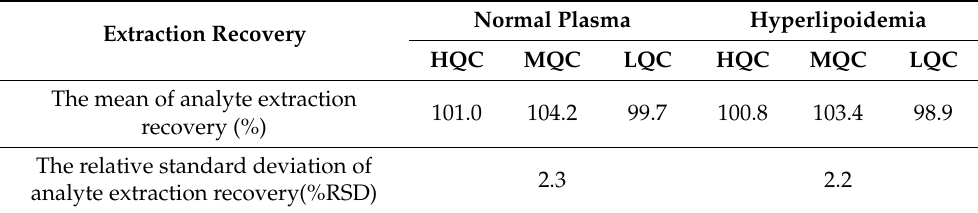
Table 3. The extraction recovery results.